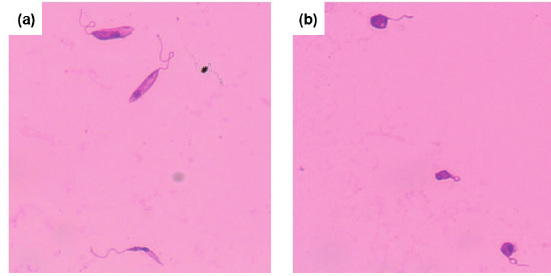
Figure 5 - Optical microscopy views of parasite cultures ( a ) exposed to AuNPs-TA and ( b ) exposed to AgNPs-TA. Quick panoptic staining and 100x magnification.